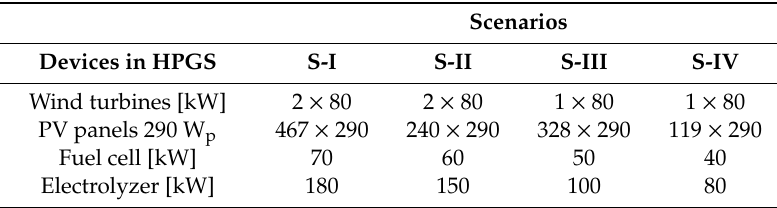
Table 1. Nominal power of generation devices in HPGS to supply the consumer according to a given scenario.